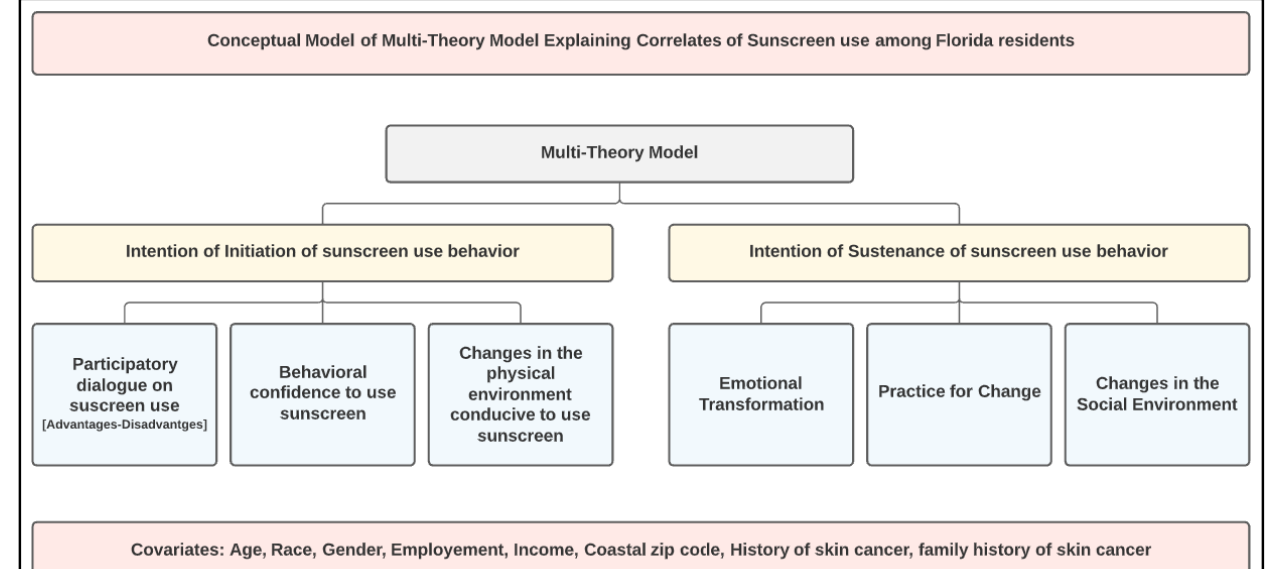
Figure 1. Multi-theory model framework.